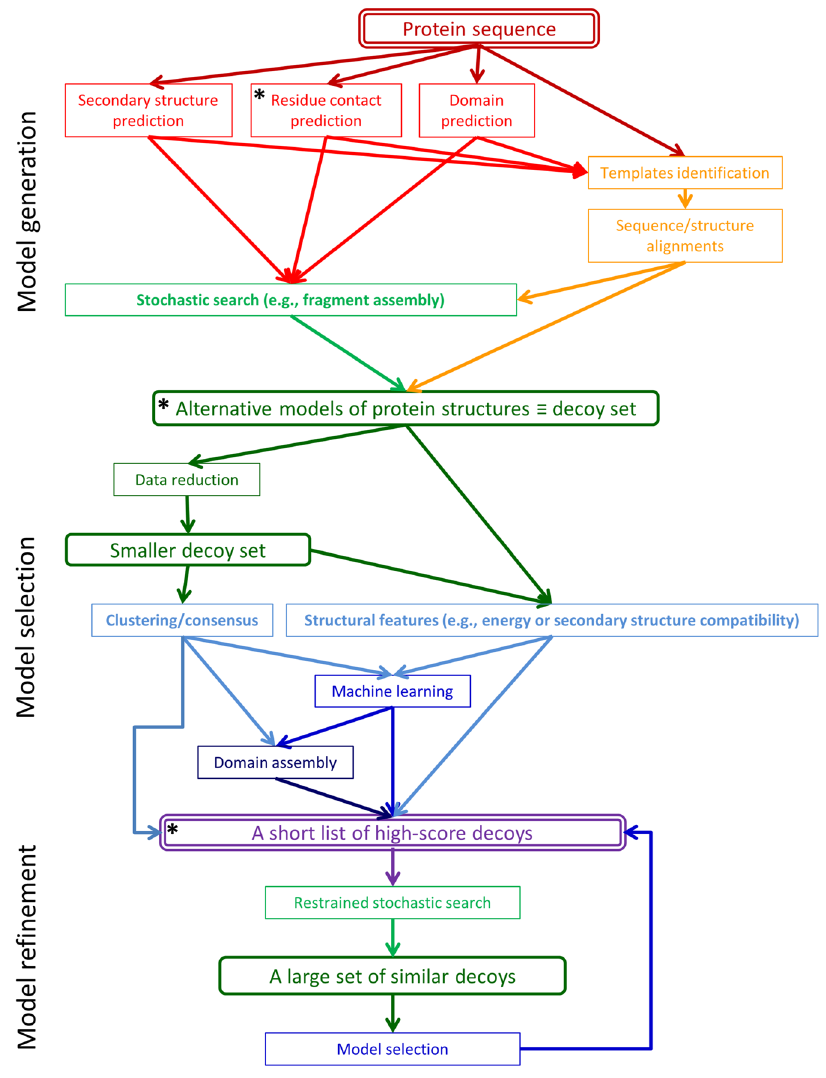
Figure 1. A schematic depiction of the multi-step and multi-path information flow of protein structure prediction. Rounded rectangles represent information and plain rectangles represent basic tasks, each of which is an open computational problem. A prediction process starts with a protein sequence, passes at least once through a set of decoys (structural models of proteins), and ends with a short list, ideally one, of high score decoys. The paths in this graph are not mutually